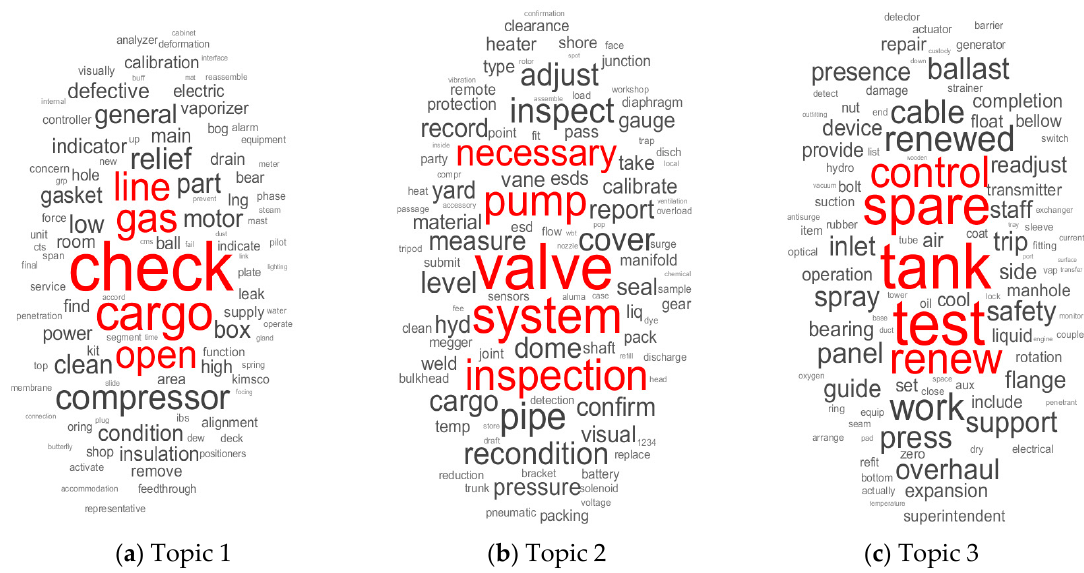
Figure 6. Topic model of LNGCs aged less than 10 years. ( a ) Topic 1: check-cargo-gas-line; ( b ) Topic 2: valve-system-inspection-pump; ( c ) Topic 3: tank-test-spare-renew.